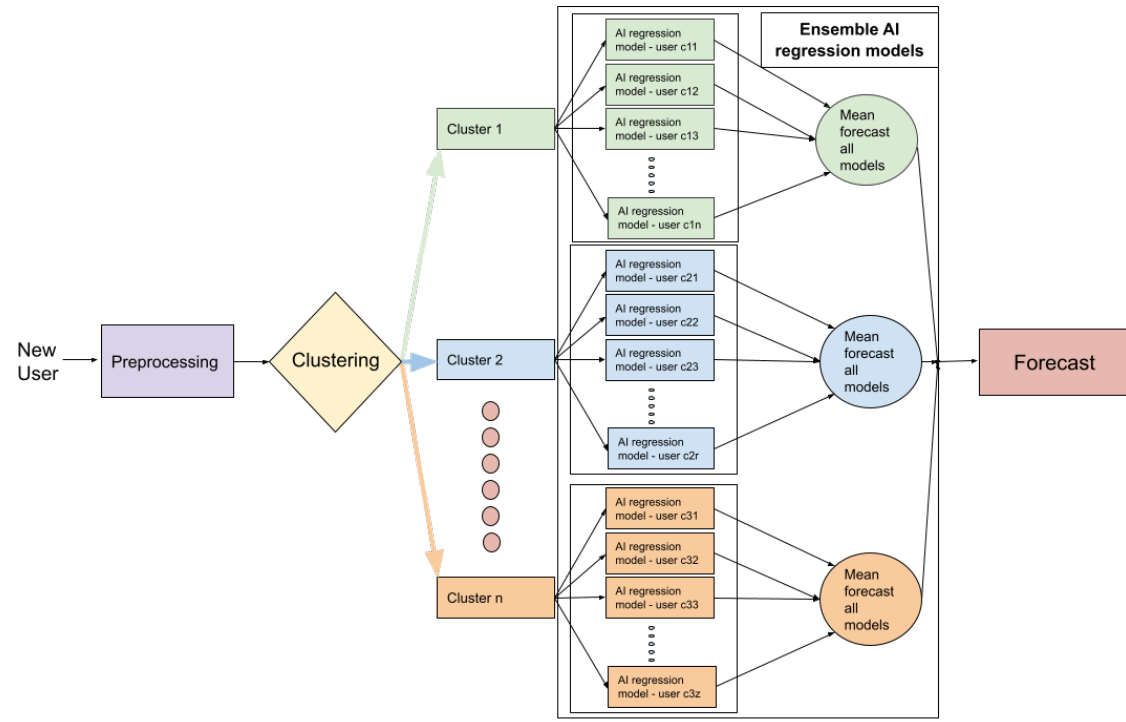
Figure 3. Proposed architecture to determine user adherence to physical exercise in the MH fitness